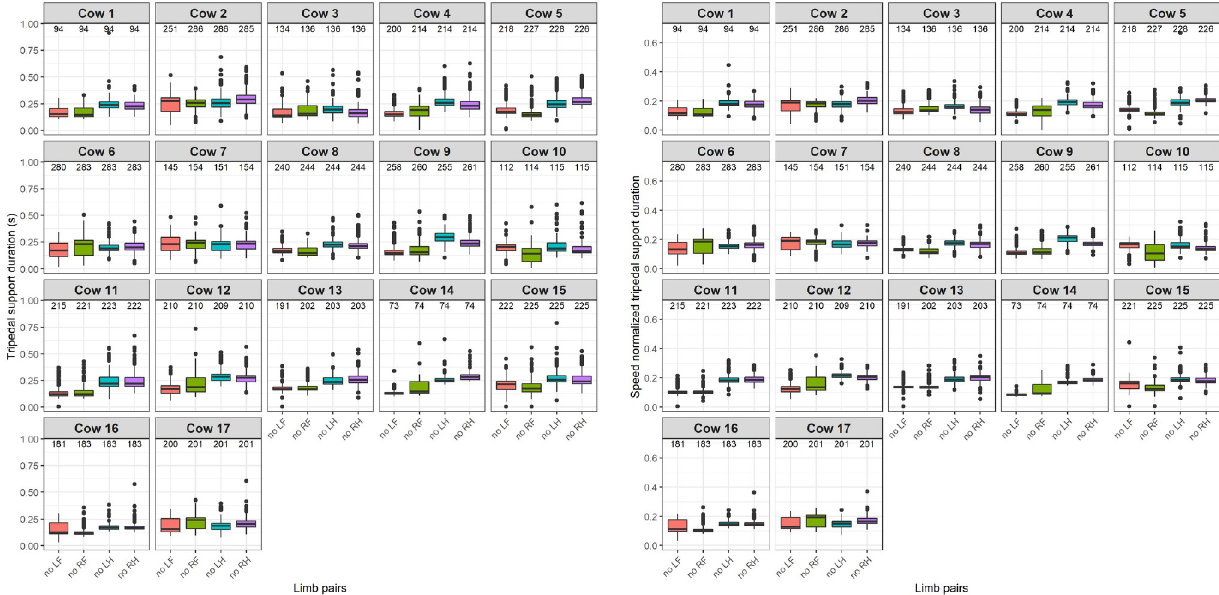
Fig 5. Distributions of tripedal support durations (left panel) and speed normalized tripedal support durations (right panel) for every cow and limb pair combinations separately. In red: no LF, green: no RF, blue: no LH and purple: no RH. The number of selected strides per limb is shown above the boxes. The spacing of the boxplot shows the range between the first and third quartile, the median is indicated with the black line, the whiskers show the range of the maxima and minima and the outliers are indicated with dots.